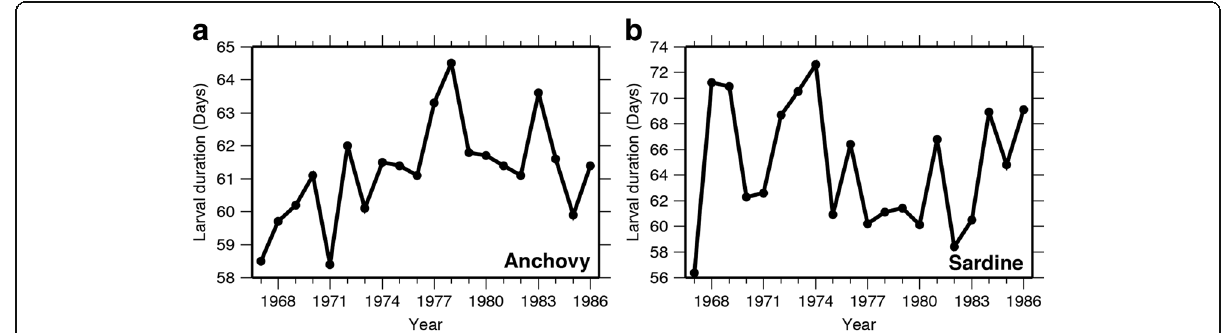
Fig. 6 Time series of simulated a anchovy larval duration and b sardine larval duration for 1967 to 1986 of the historical